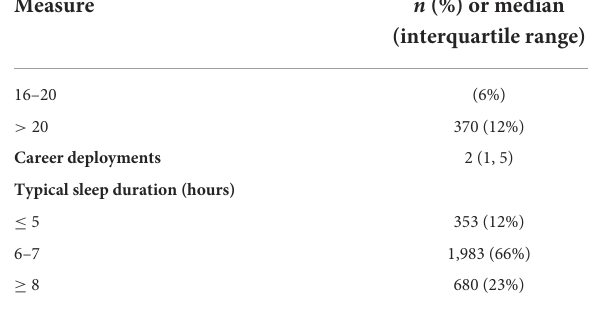
TABLE 1 Participant demographics ( n = 3,022).